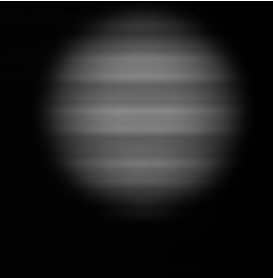
Figure 13. The VLP-LED stripe images with diffusion blur with a diffusion blur radius of 40 in pixels.